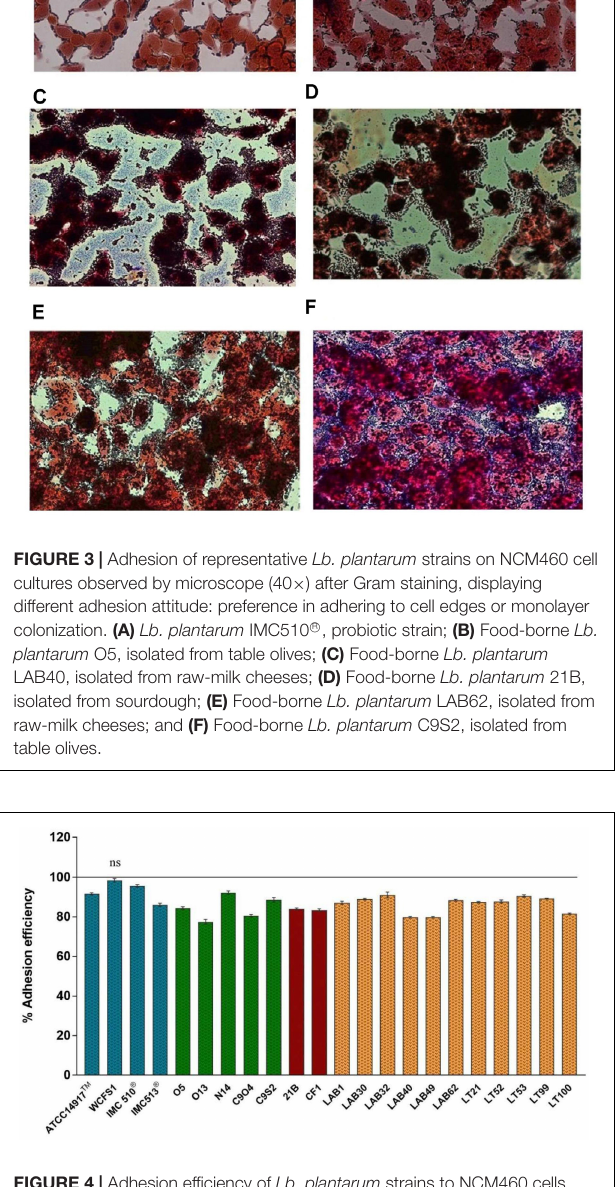
FIGURE 4 | Adhesion efficiency of Lb. plantarum strains to NCM460 cells. Values are expressed as mean ± SEM. p < 0.0001 versus control; ns = not statistically significant; and 100% = initial bacterial